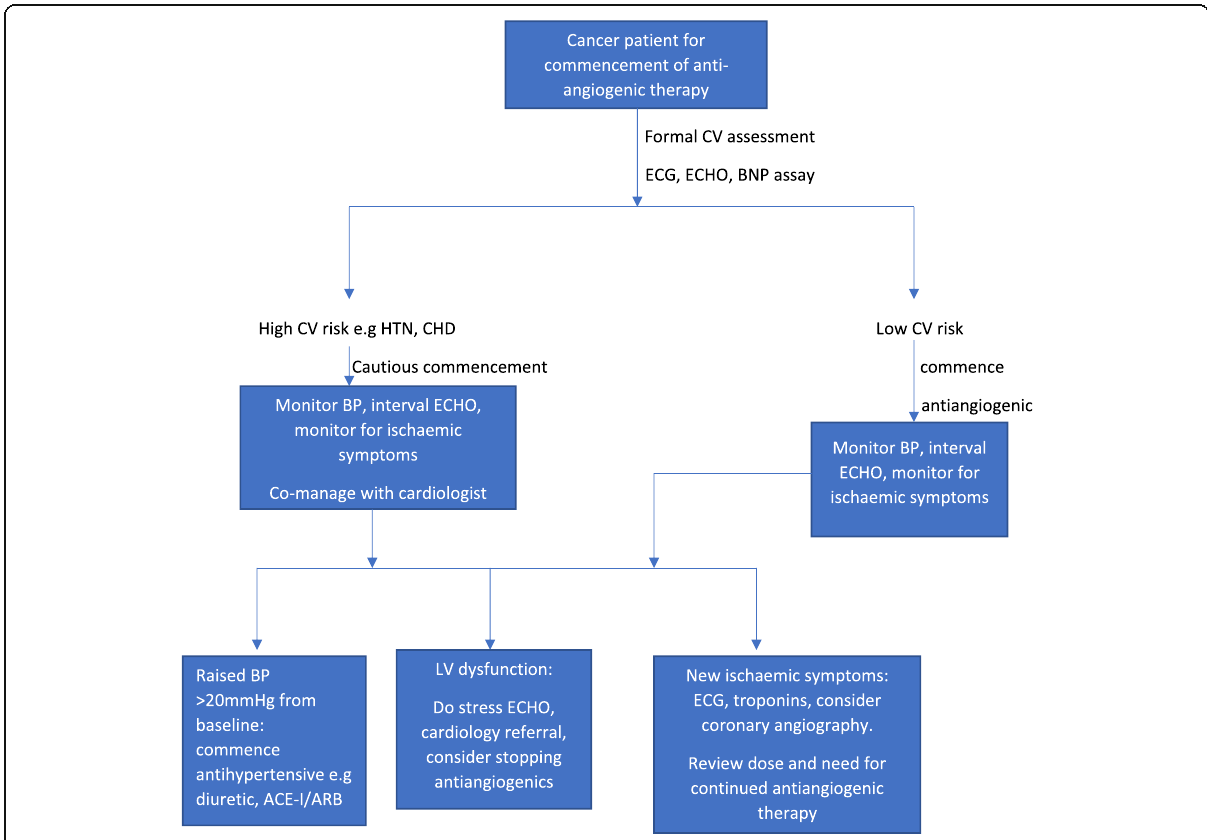
Fig. 1 Clinical approach to cardiovascular toxicity of antiangiogenic